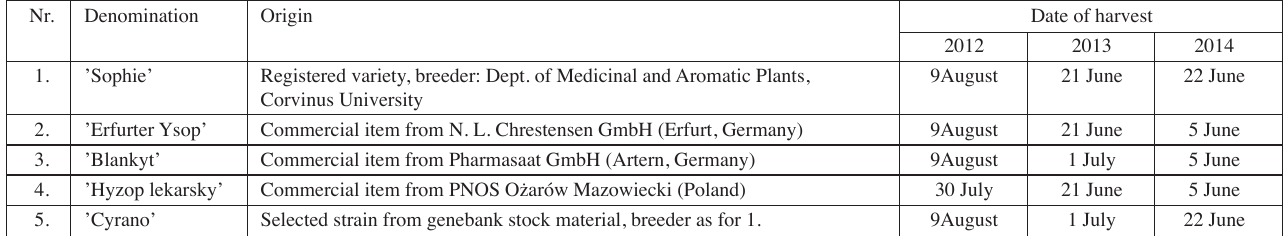
Tab. 1: The examined accessions of hyssop and their harvest times